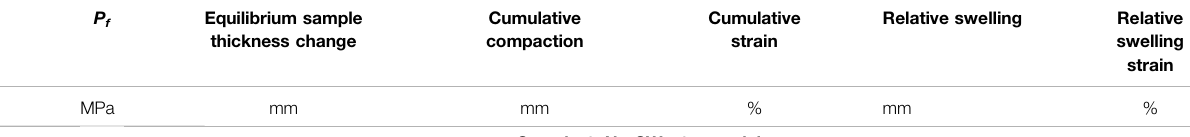
Sample 1: Na-SWy-1 material